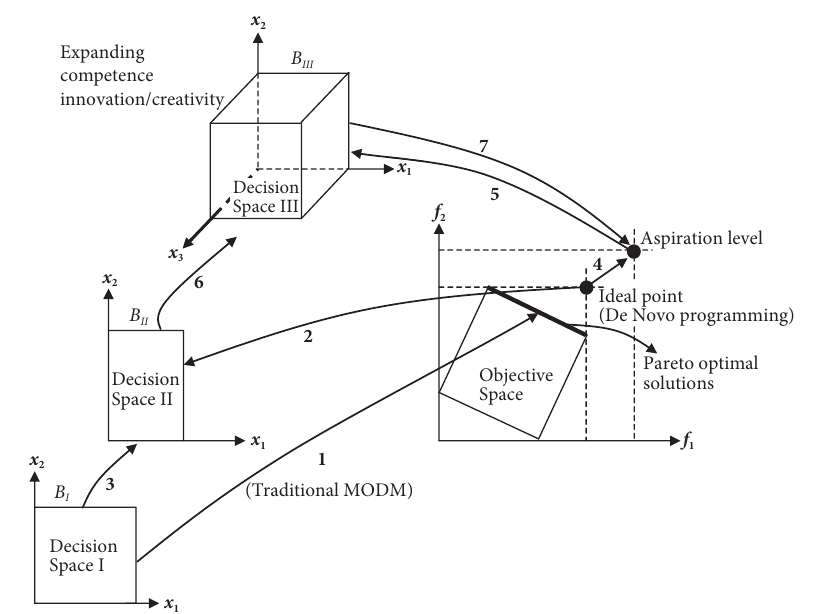
Fig. 5. The concepts of changeable decision space and aspiration